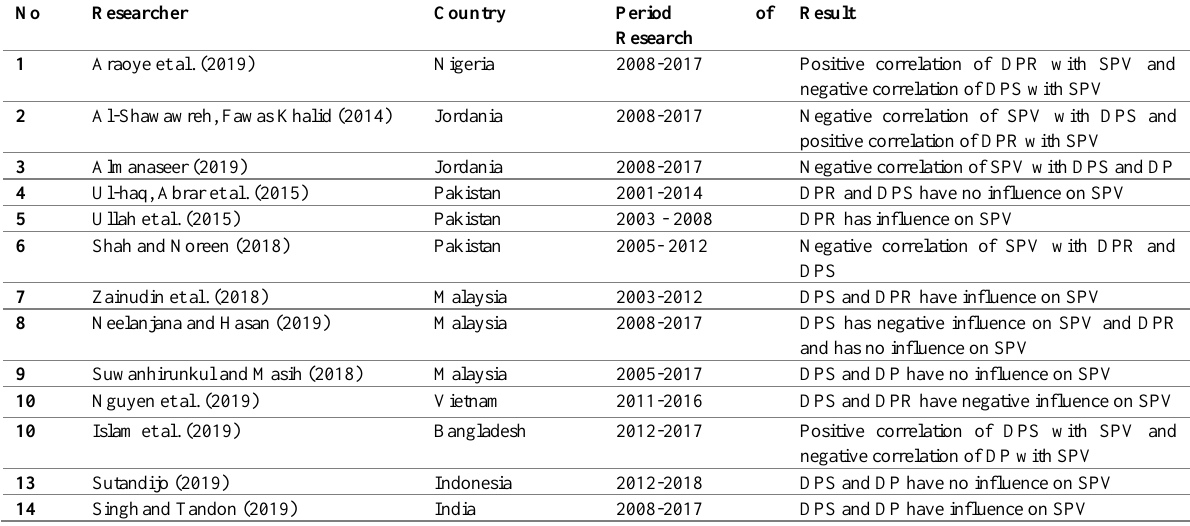
Table 1: Summary of Empirical